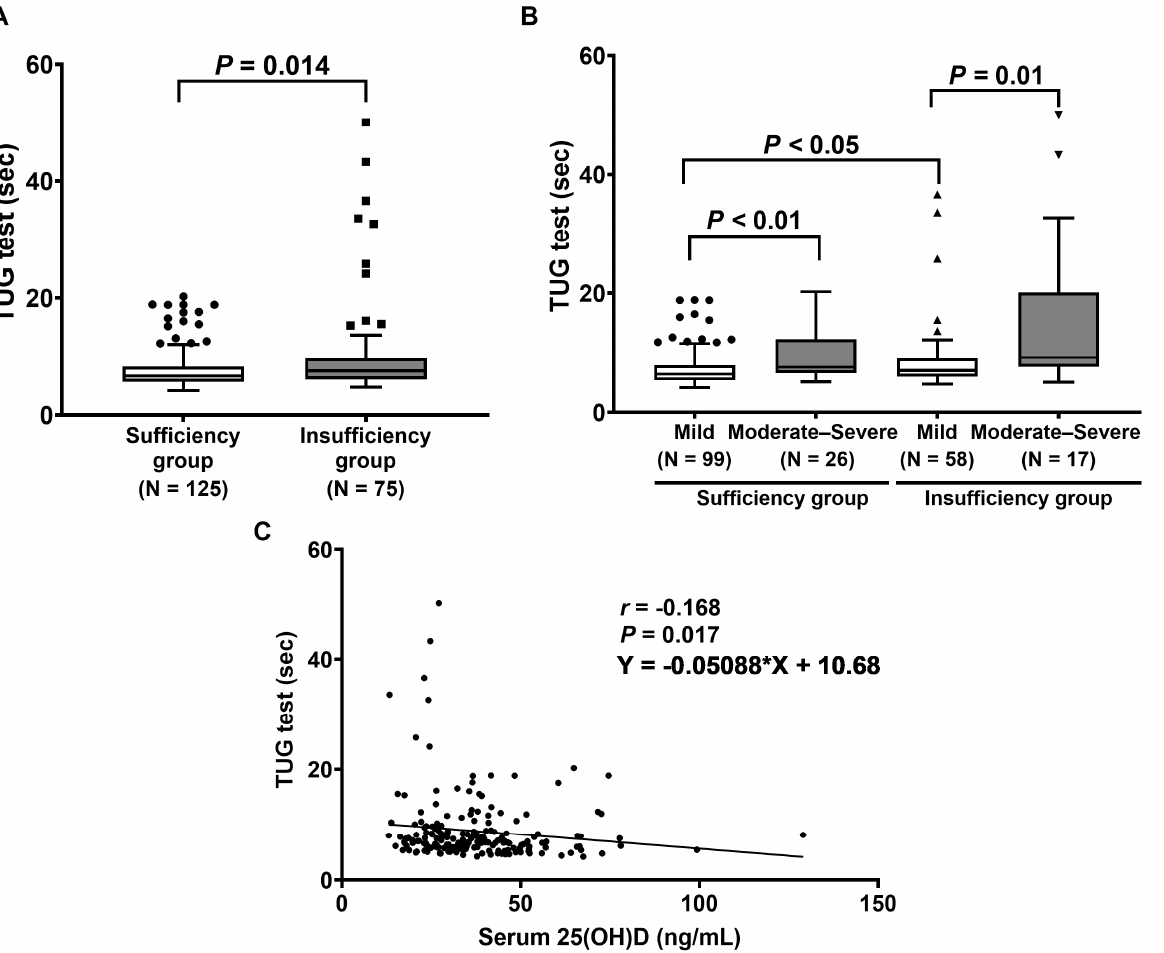
Figure 4. Determination of TUG test: ( A ) Comparison of TUG test between patients with vitamin D sufficiency and insufficiency. p -value was analyzed using the Mann–Whitney U test. ( B ) Comparison of TUG test between patients, classified by ODI score. p -value was calculated with Friedman’s two-way ANOVA test. ( C ) Correlation between serum 25(OH)D and the time in the TUG test.